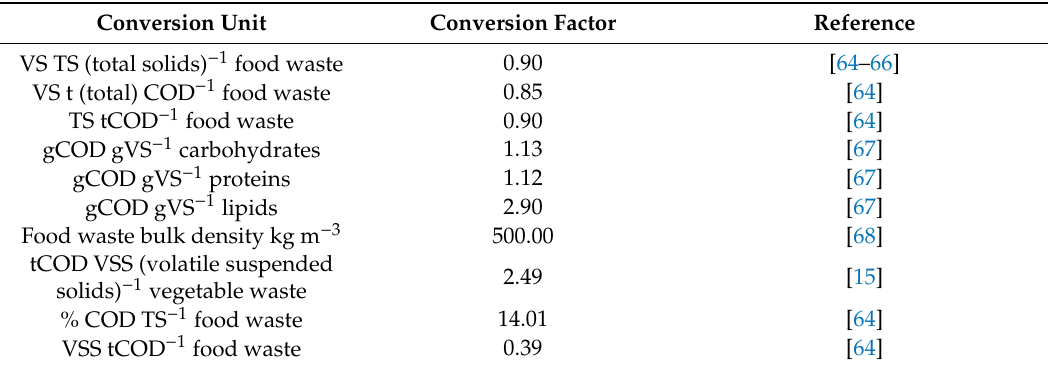
Table 1. Conversion factors used in this